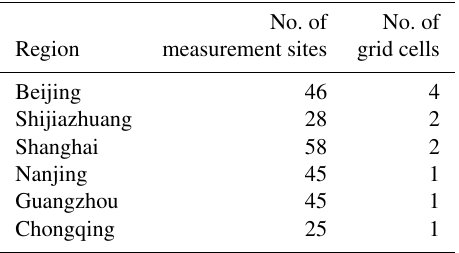
Table 1. Number of measurement sites and grid cells in the six in- dustrial regions. No. of No. of Region measurement sites grid cells Beijing 46 4 28 2 58 2